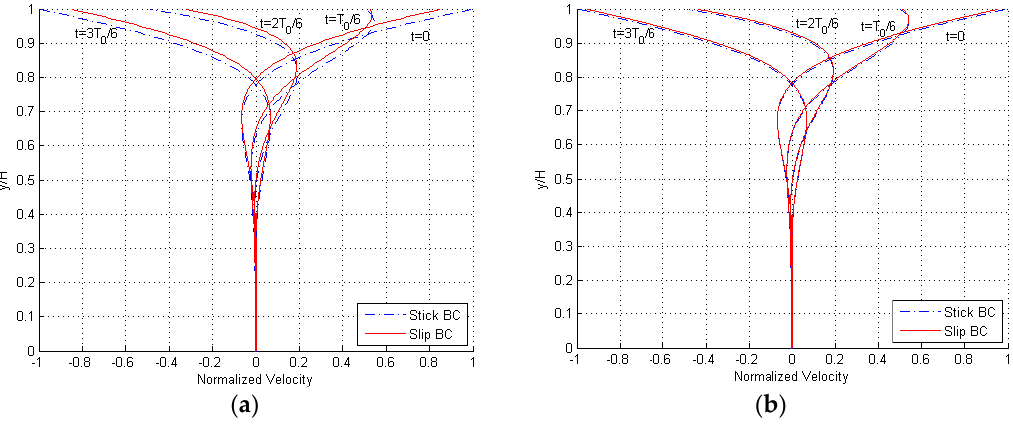
profile at varying frequency f of oscillation of the moving plate at y = H , for both stick and slip BCs.